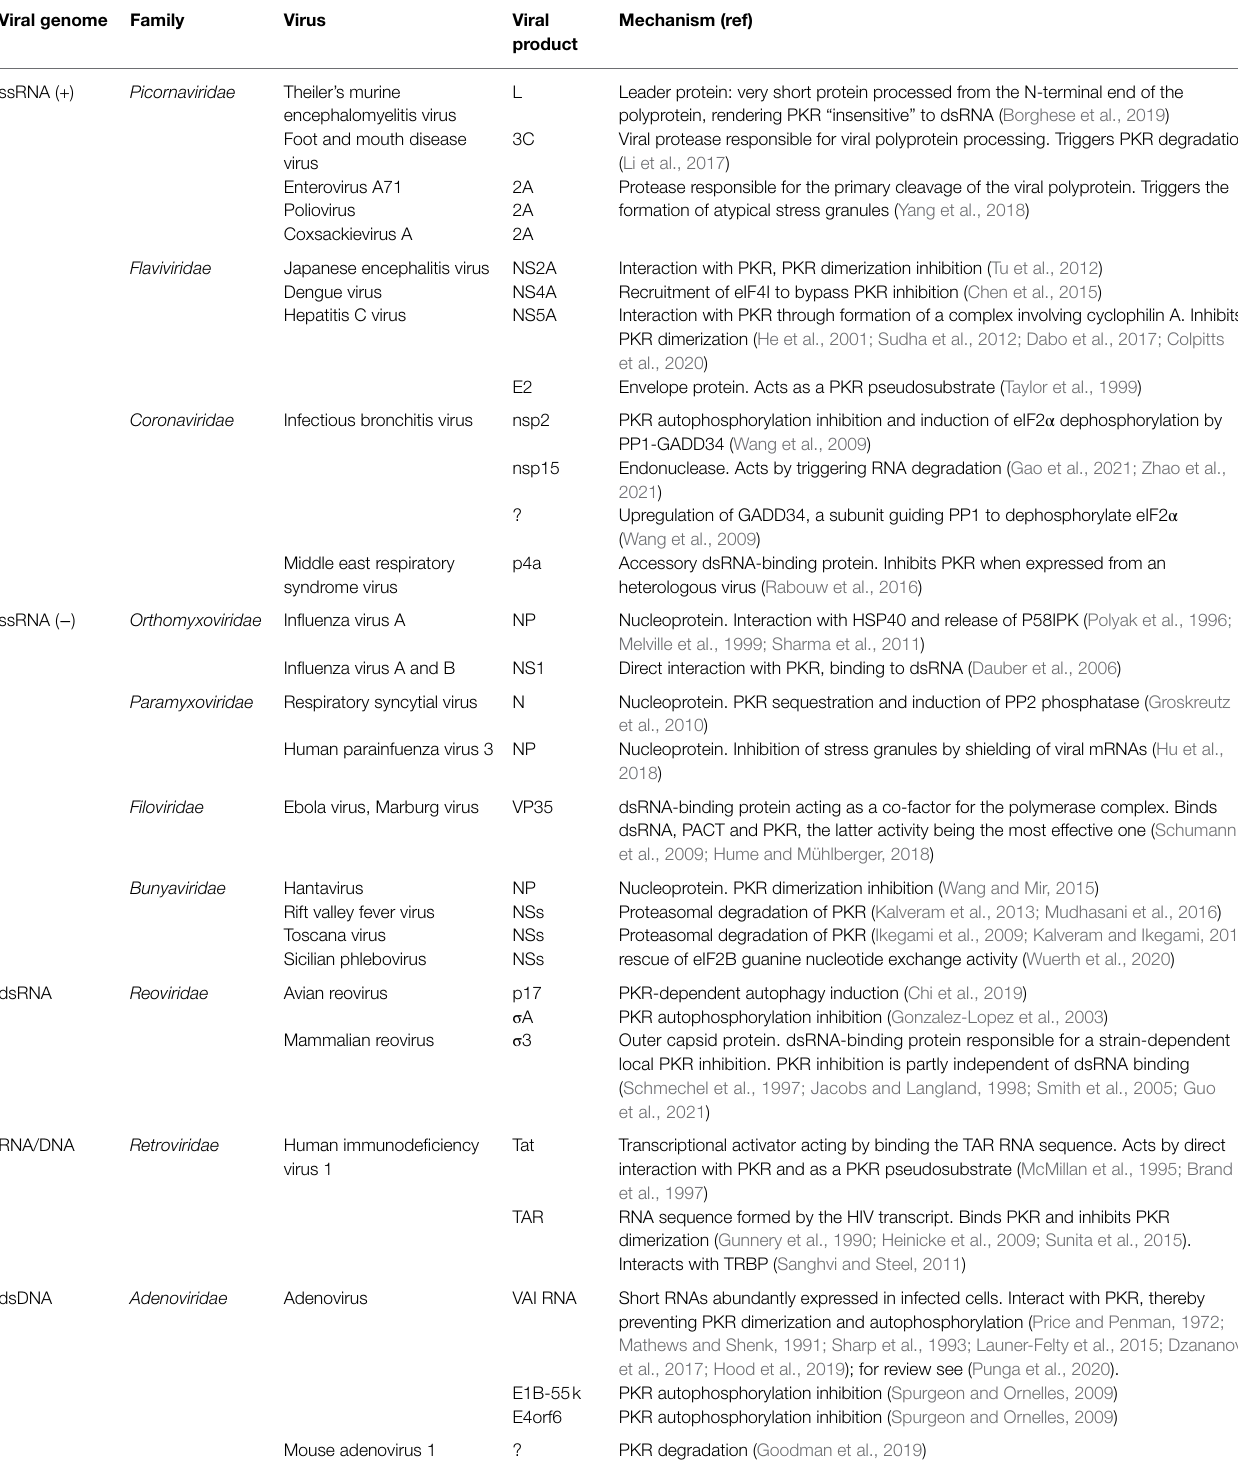
TABLE 1 | Strategies developed by viruses to escape PKR-mediated antiviral response. Viral genome